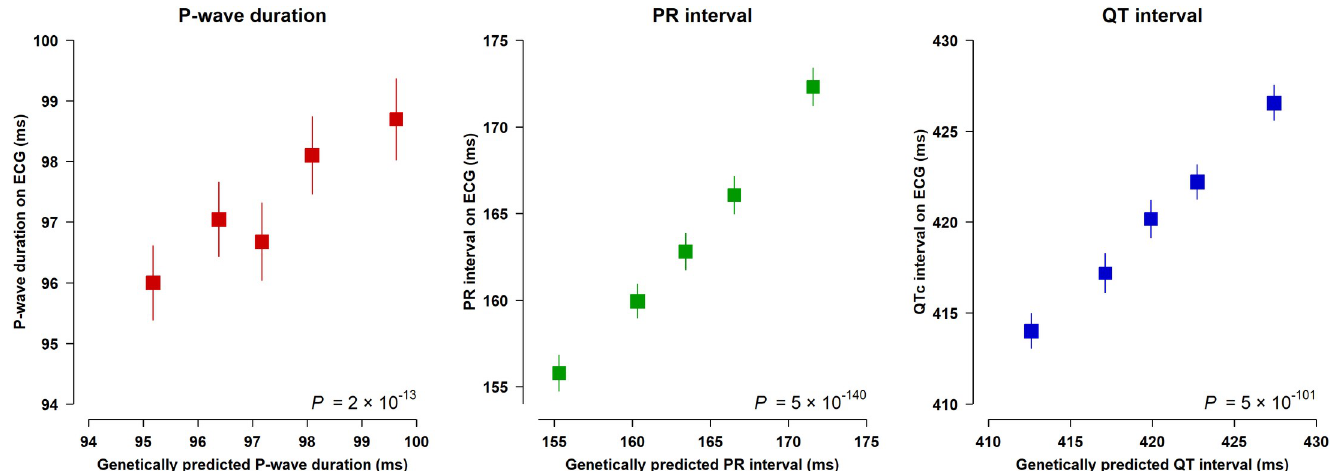
Fig 1. Associations between genetic scores and 12-lead ECG parameters in UK Biobank. Association between quintiles of genetic scores for ECG parameters (defined in non-AF cases) and 12-lead ECG parameters in 13,314 participants in UK Biobank. Boxes represent mean values with their size inversely proportional to variance, and lines represent 95% CIs. A constant representing the population mean nongenetically predicted ECG interval was added to all genetic score values (the population mean of measured 12-lead ECG parameter excluding the genetic contribution; 93.2 ms for P-wave duration, 93.5 ms for PR interval, and 360.7 ms for QT interval) for display purposes. P calculated across the genetic score using linear regression adjusting for sex, genotyping array, and 40 principal components of ancestry. AF, atrial fibrillation; CI, confidence interval; ECG, electrocardiographic.